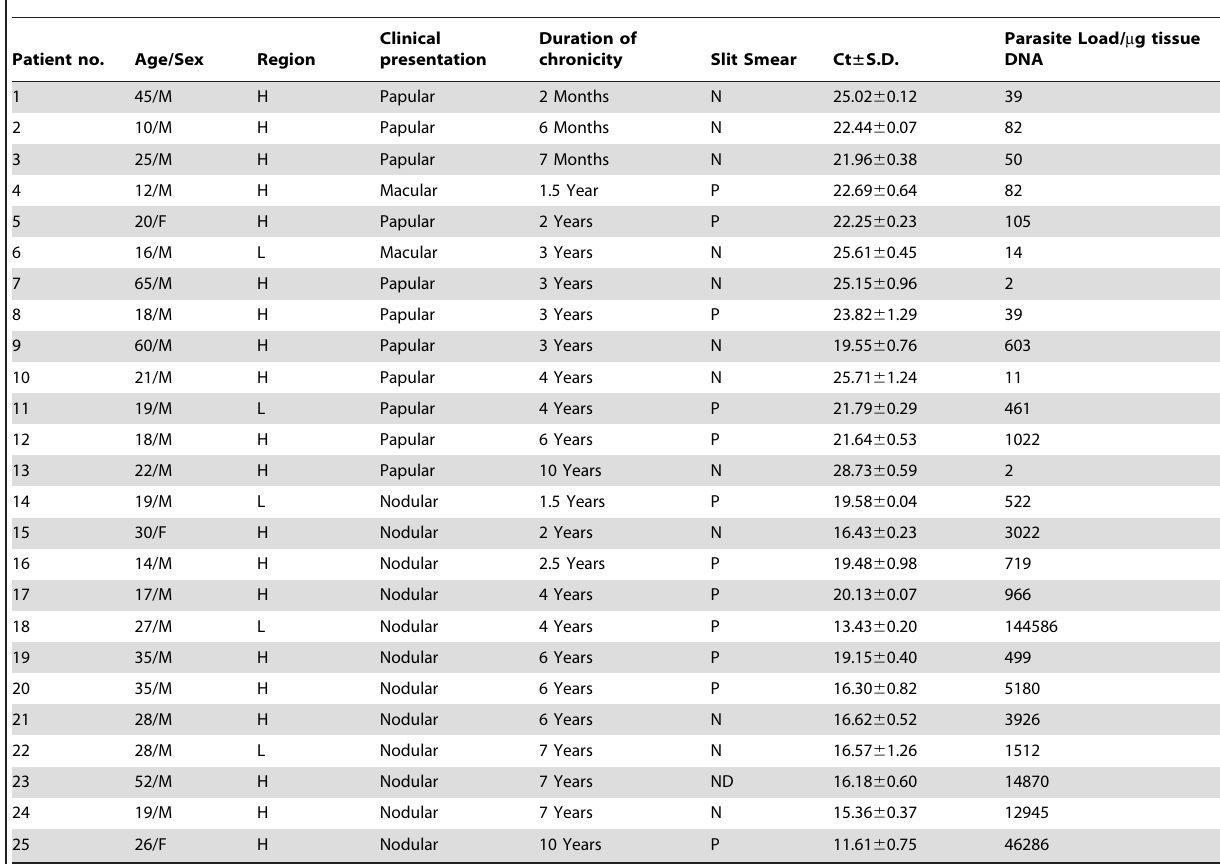
Table 3. Clinical presentation and results of real-time PCR assay in dermal lesions of PKDL patients.